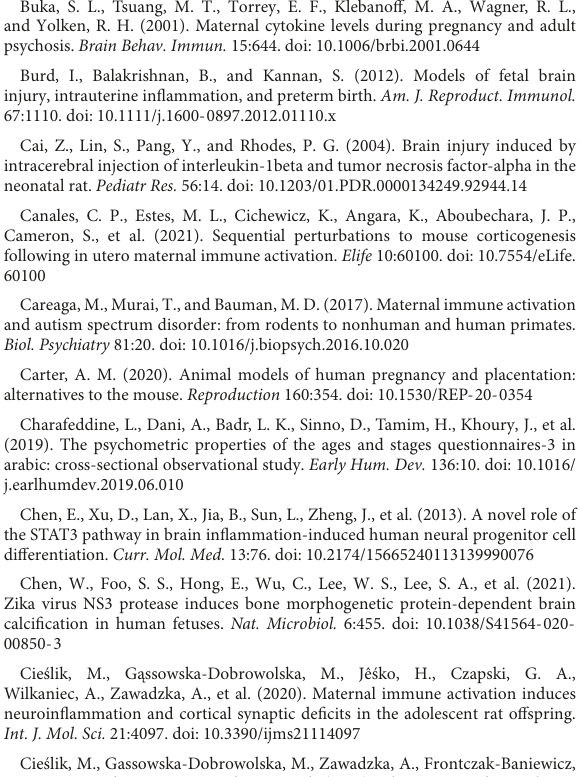
Figueiredo, C. P., Fontes-Dantas, F. L., da Poian, A. T., and Clarke, J. R. (2021). SARS-CoV-2-associated cytokine storm during pregnancy as a